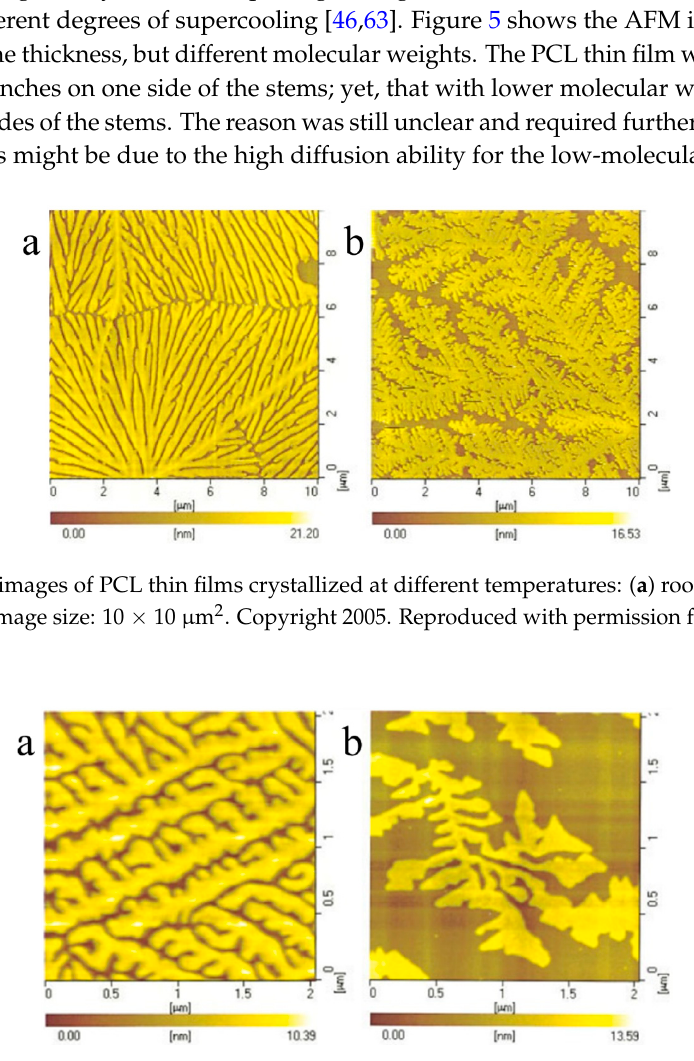
Figure 5. Effect of molecular weight on morphology of PCL thin films crystallized at 42 °C for 20 min: ( a ) M w = 146,000; ( b ) M w = 65,000 [58]. Image size: 2 × 2 μ m 2 . Copyright 2005. Reproduced with permission from John Wiley & Sons.